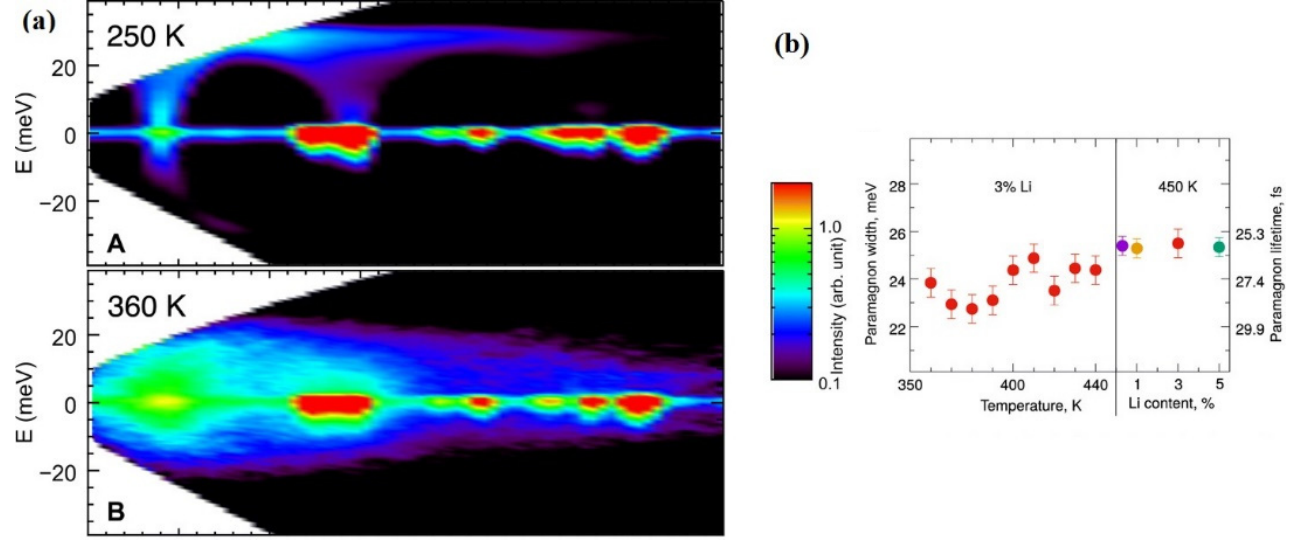
Figure 2. Neutron measurements revealing ( a ) the existence of paramagnons and ( b ) paramagnon lifetime. Adapted from Science Advances 2019, 5, eaat9461 [32]. © The Authors, some rights reserved; exclusive licensee AAAS. Distributed under a CC BY-NC 4.0 license http://creativecom- mons.org/licenses/by-nc/4.0/ (accessed on 25 July 2022). Reprinted with permission from AAAS.